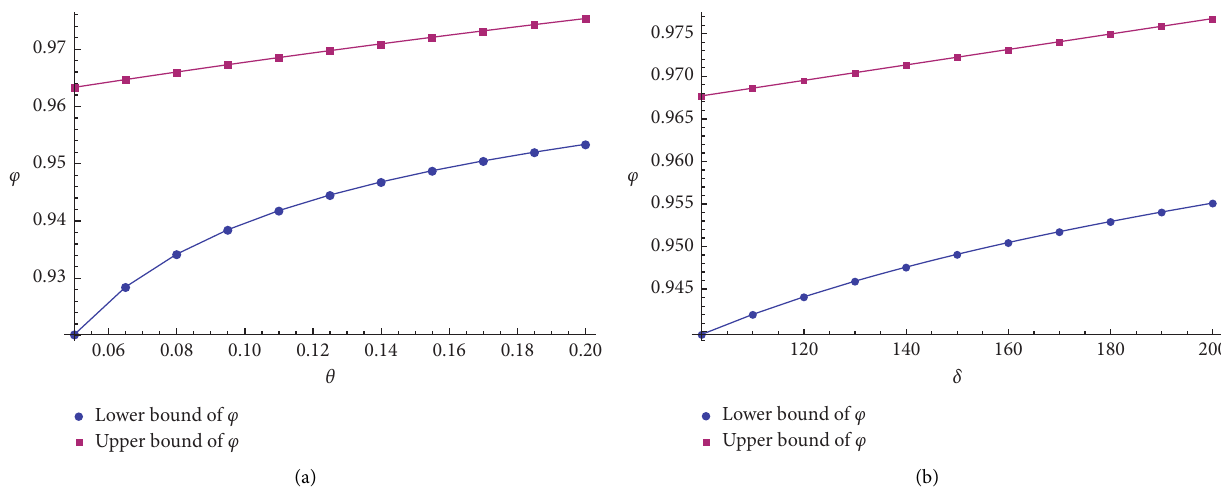
Figure 3: Change in bounds of ϕ in the mode with fairness concerns: (a) change in bounds of ϕ with θ ; (b) change in bounds of ϕ with δ .